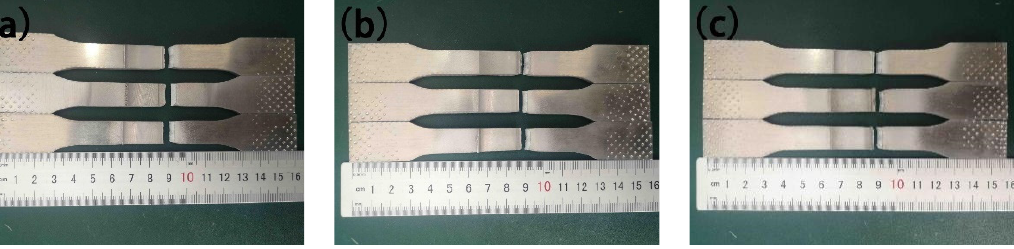
Figure 10. Fracture location diagram of tensile specimens of welded joints with different shapes of pin. ( a ) tool A ( b ) tool B ( c ) tool C.